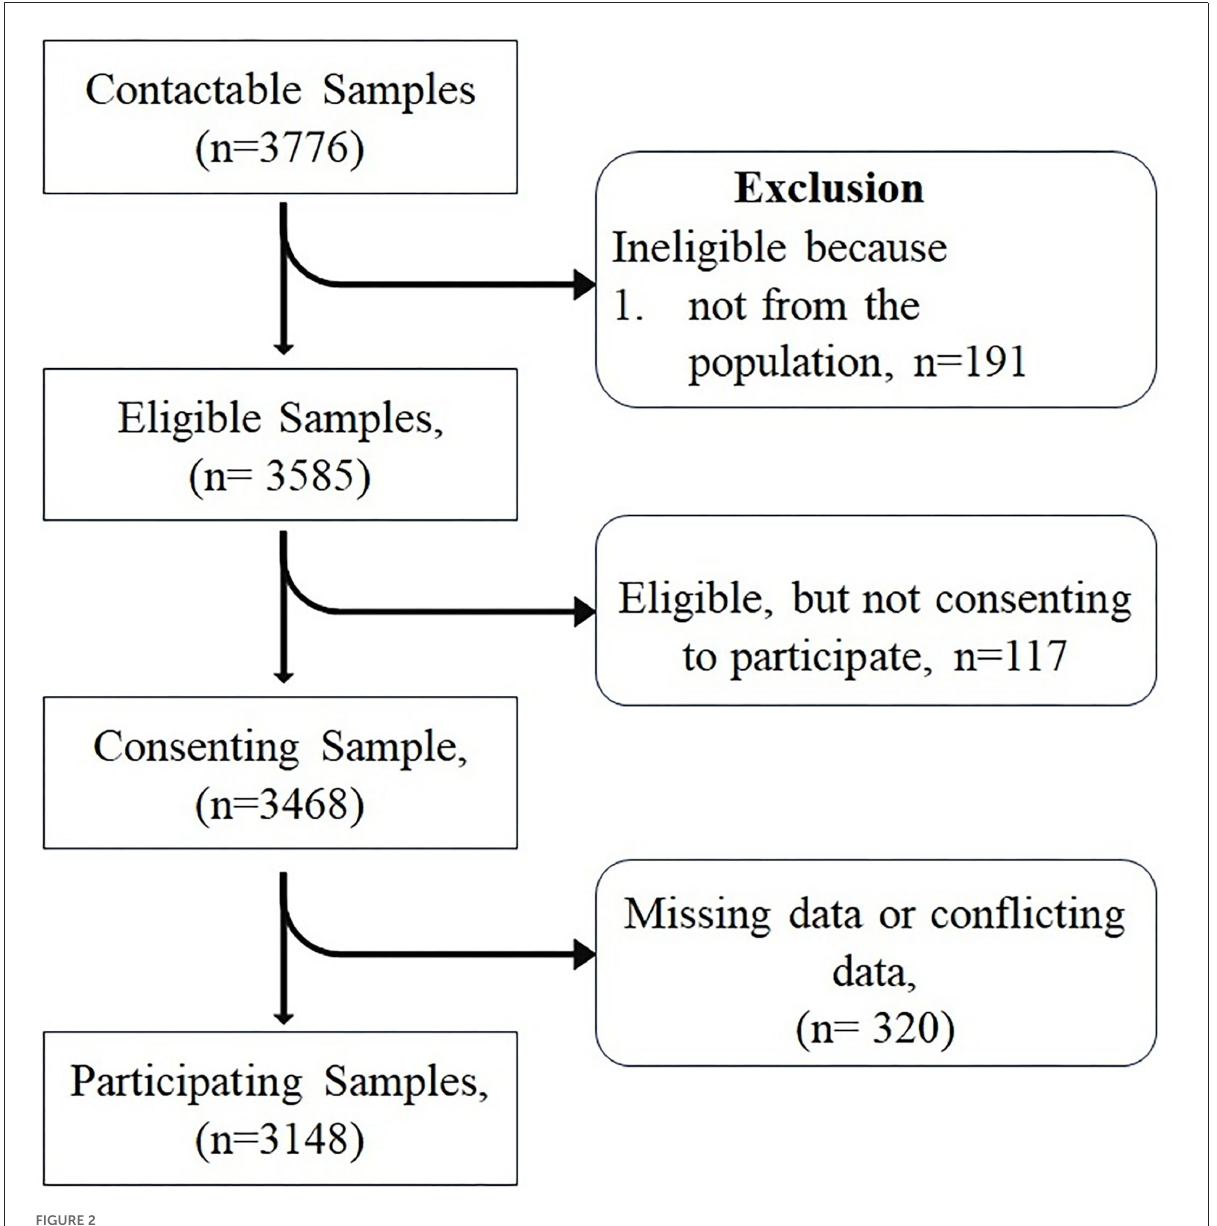
FIGURE2 Flowchart of